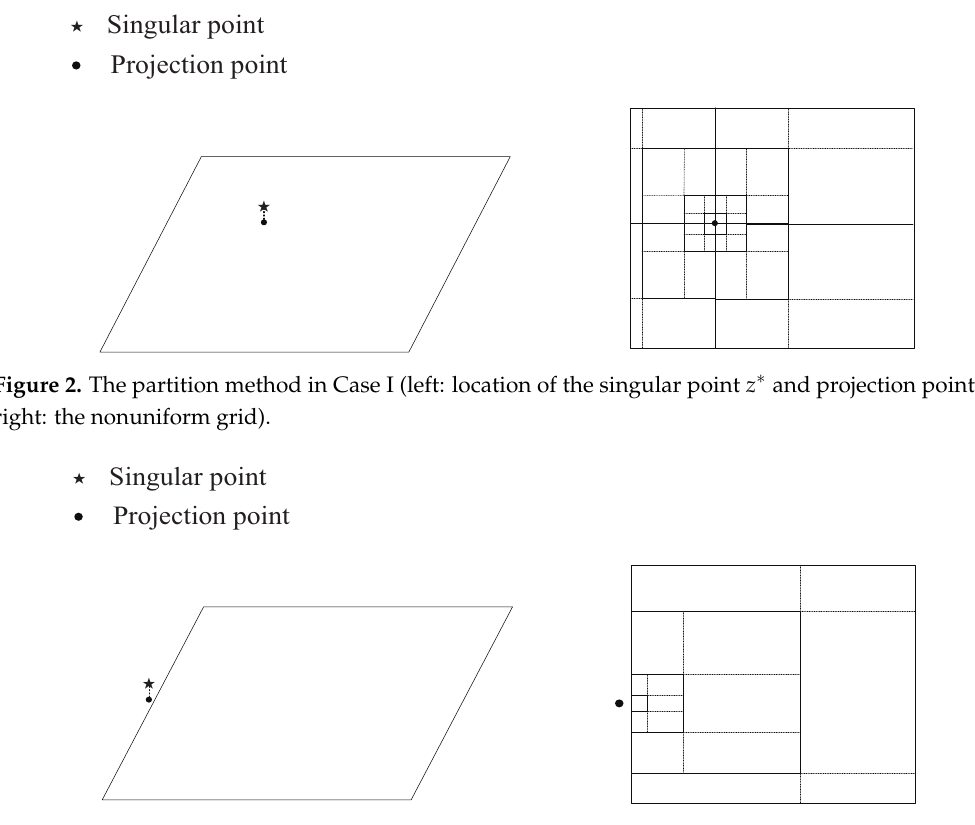
Figure 3. The partition method in Case II (left: location of the singular point z ∗ and projection point z . right: the nonuniform